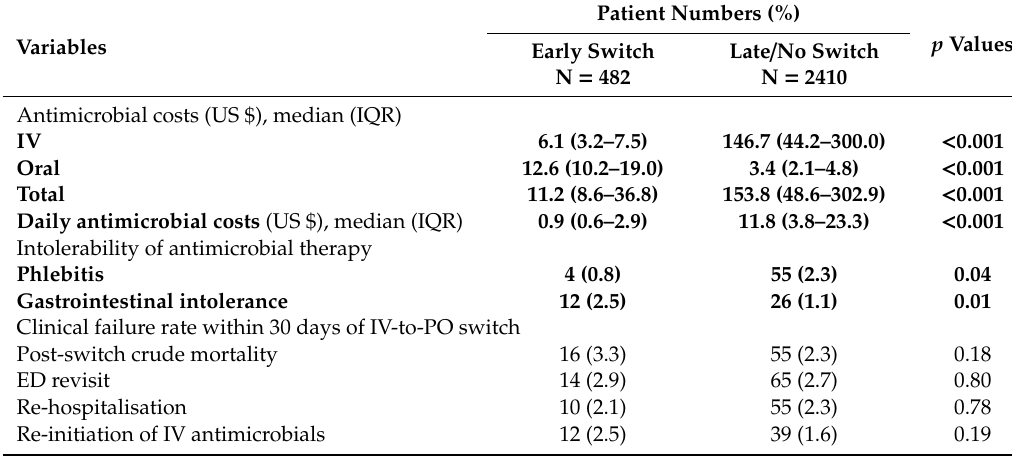
Table 3. The antimicrobial cost, intolerability, and clinical failure rate of matched patients receiving early and late / no